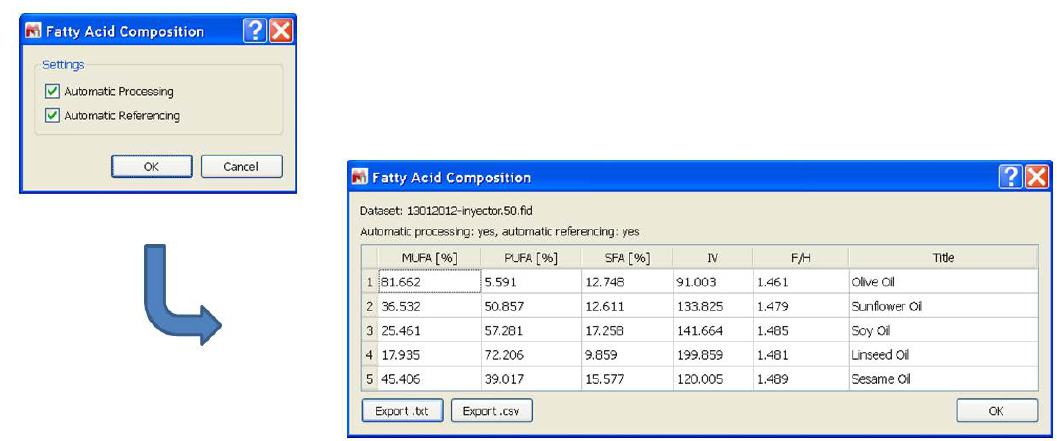
Figure 3. Result window shown in MestReNova after completing the automatic analysis.